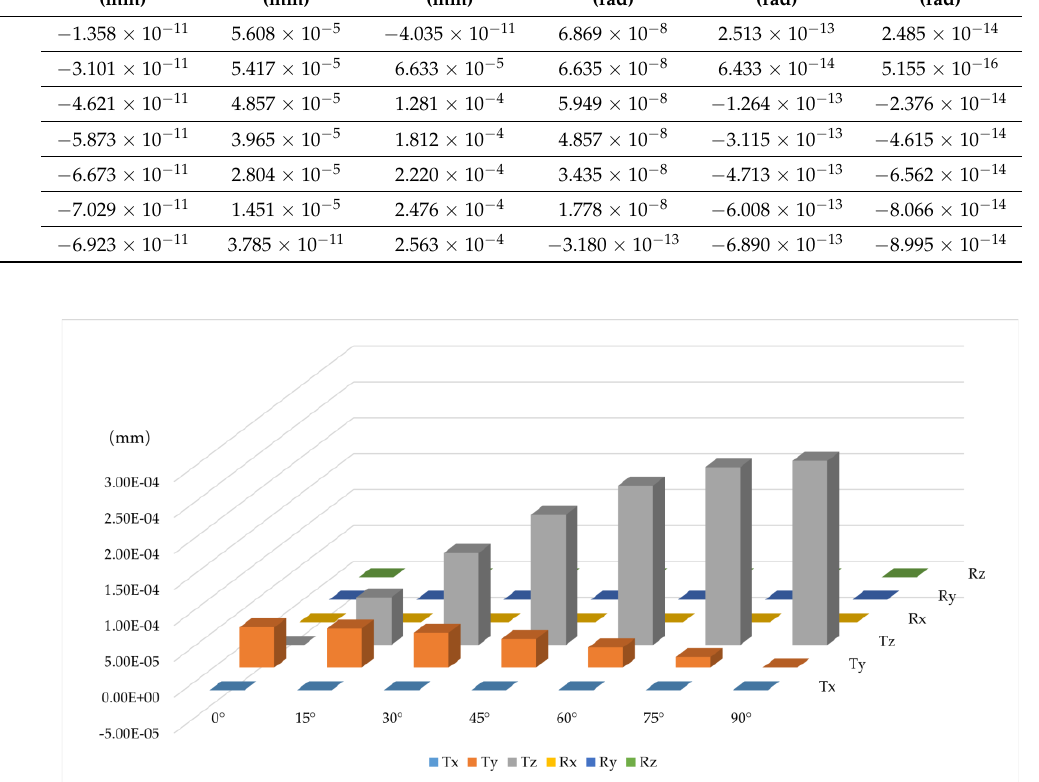
Figure 9. Plots of rigid body displacement error of L1S1 on a log scale.